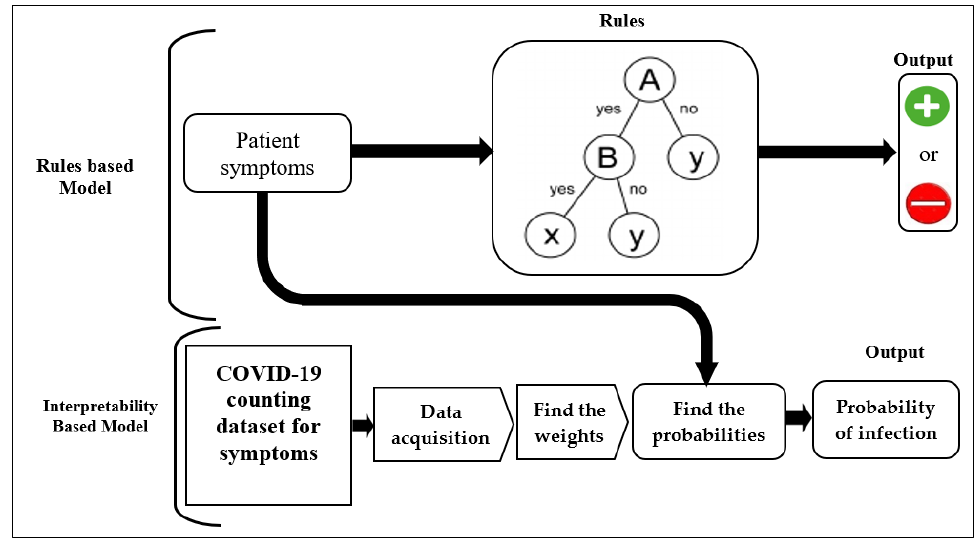
Figure 1. Using the interpretability-based model to interpret the predictions of the rules-based model for COVID-19 patients given their symptoms.